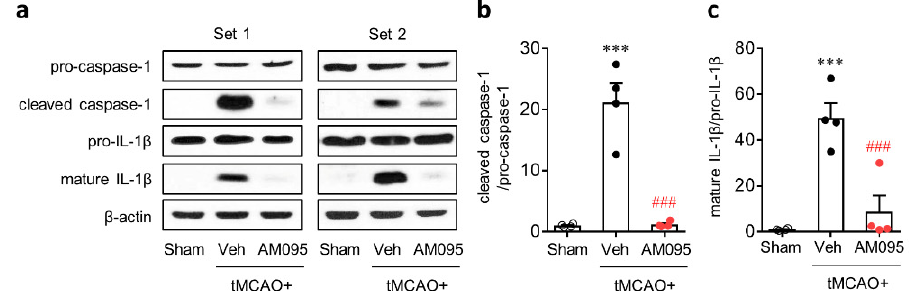
Figure 3. LPA 1 antagonist attenuates NLRP3 inflammasome activation in injured brains after tMCAO challenge. Mice were induced with tMCAO. AM095 (30 mg / kg) was administered immediately after reperfusion. Caspase-1 activation and interleukin 1 β (IL-1 β ) maturation were determined by Western blot analysis at 1 day after tMCAO challenge. Representative Western blots of pro-caspase-1, cleaved caspase-1, pro-IL-1 β , and mature IL-1 β ( a ) and quantification of caspase-1 activation ( b ) and IL-1 β maturation ( c ) are shown. n = 4 mice per group. *** p < 0.001 versus sham. ### , p < 0.001 versus vehicle-administered tMCAO group. Neurological deficit scores of mice used for Western blot analysis are presented as a supplementary figure (Figure S1c).